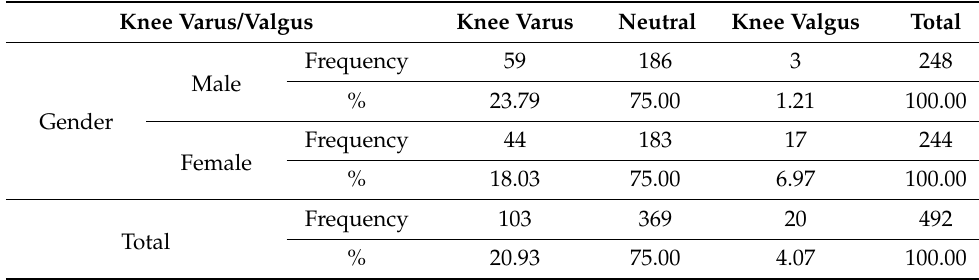
Table 15. The result of cross-tabulation analysis between gender and knee varus/valgus (X 2 = 11.98, df = 2, p =